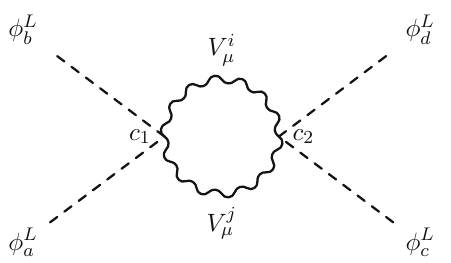
Fig. 2 One-loop diagram contributing to the shift from MS–DR con-